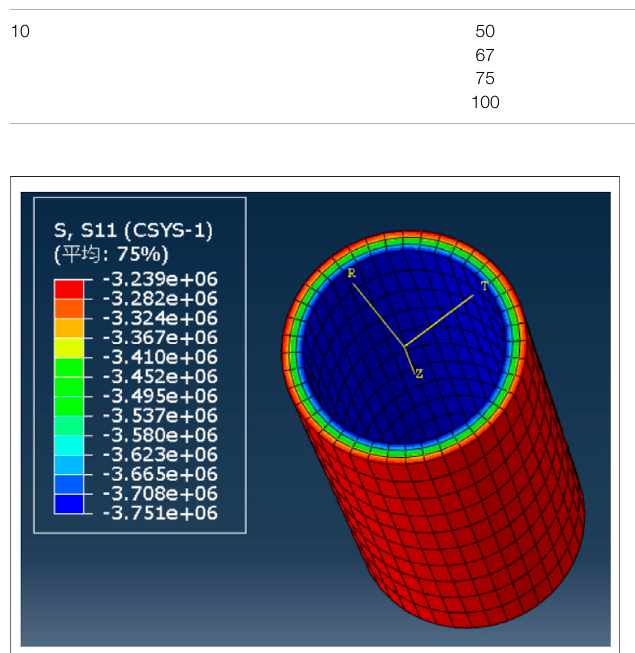
FIGURE 7 | Calculation results of the in fl uence of the preset annulus stress on the cement annulus stress.